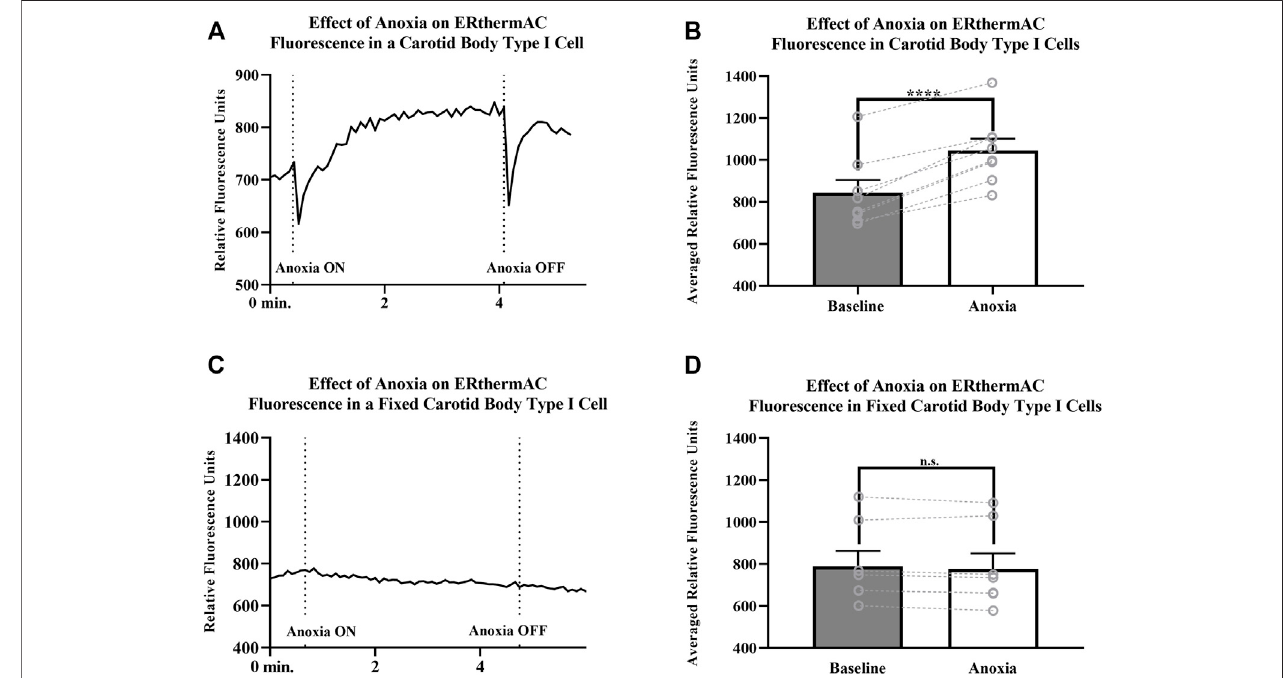
FIGURE 6 | (A) ERthermAC (250 nM) fl uorescence signals from a live, isolated Carotid Body Type I cell exposed to anoxia. Relative fl uorescent intensity increases suggestingadecrease inwhole-cell temperature asaresultofhypoxic exposure. Bathtemperatureremained constantat37 ° Cfortheentirelengthoftheexperiment (B) AveragedERthermAC(250 nM) fl uorescencesignalsfromlive,isolatedCarotidBodyTypeIcellsexposedtoanoxia.Relative fl uorescentintensityincreasessuggestinga decrease in whole-cell temperature as aresult ofanoxic exposure ( p < 0.0001, n = 8; 843.3 ± 61.1 vs 1044.8 ± 57.3 RFU) (C) Example trace showing ERthermAC (250 nM) fl uorescence in a fi xed, isolated Carotid Body Type I cell exposed to an anoxic extracellular HEPES-buffered solution. Anoxia did not cause a signi fi cant effect on ERthermAC signal fl uorescence in fi xed Carotid Body Type I cells (D) Control experiments showed no signi fi cant change in averaged ERthermAC (250 nM) signal